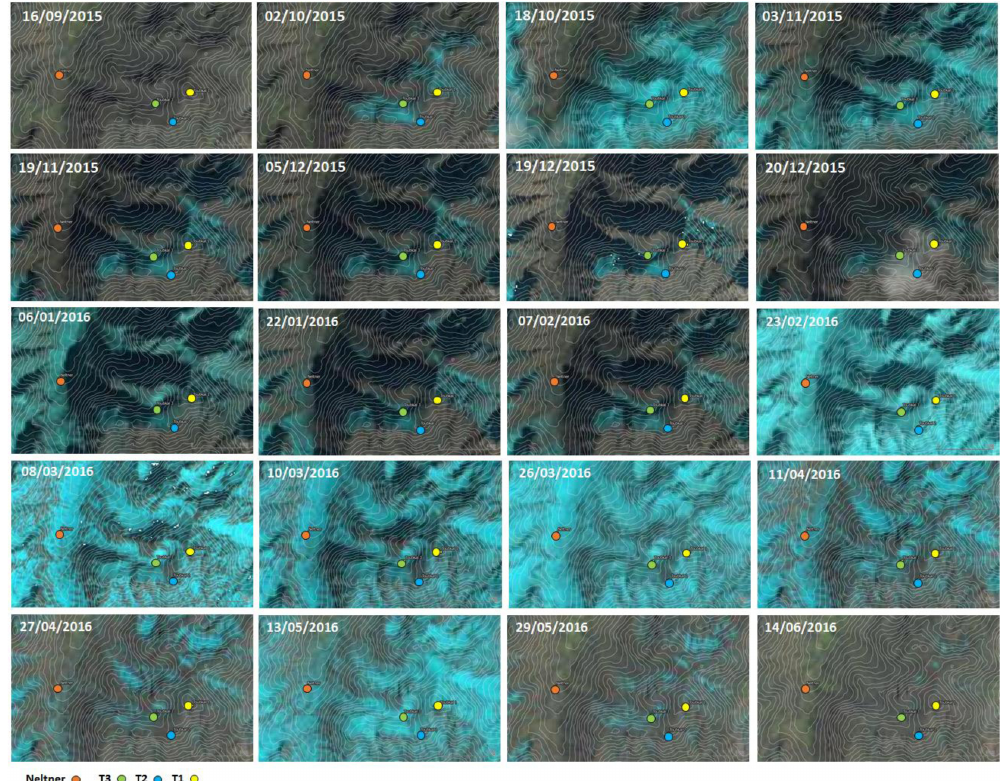
Figure 6. Satellite true colour composite scenes from Landsat 8 (USGS) and Sentinel-2 (ESA) used for assessing snow coverage at the monitoring sites (coloured dots, see legend) from September 2015 to June 2016. Light blue indicates snow cover and brown and green indicate snow-free terrain. Satellite imagery obtained from USGS